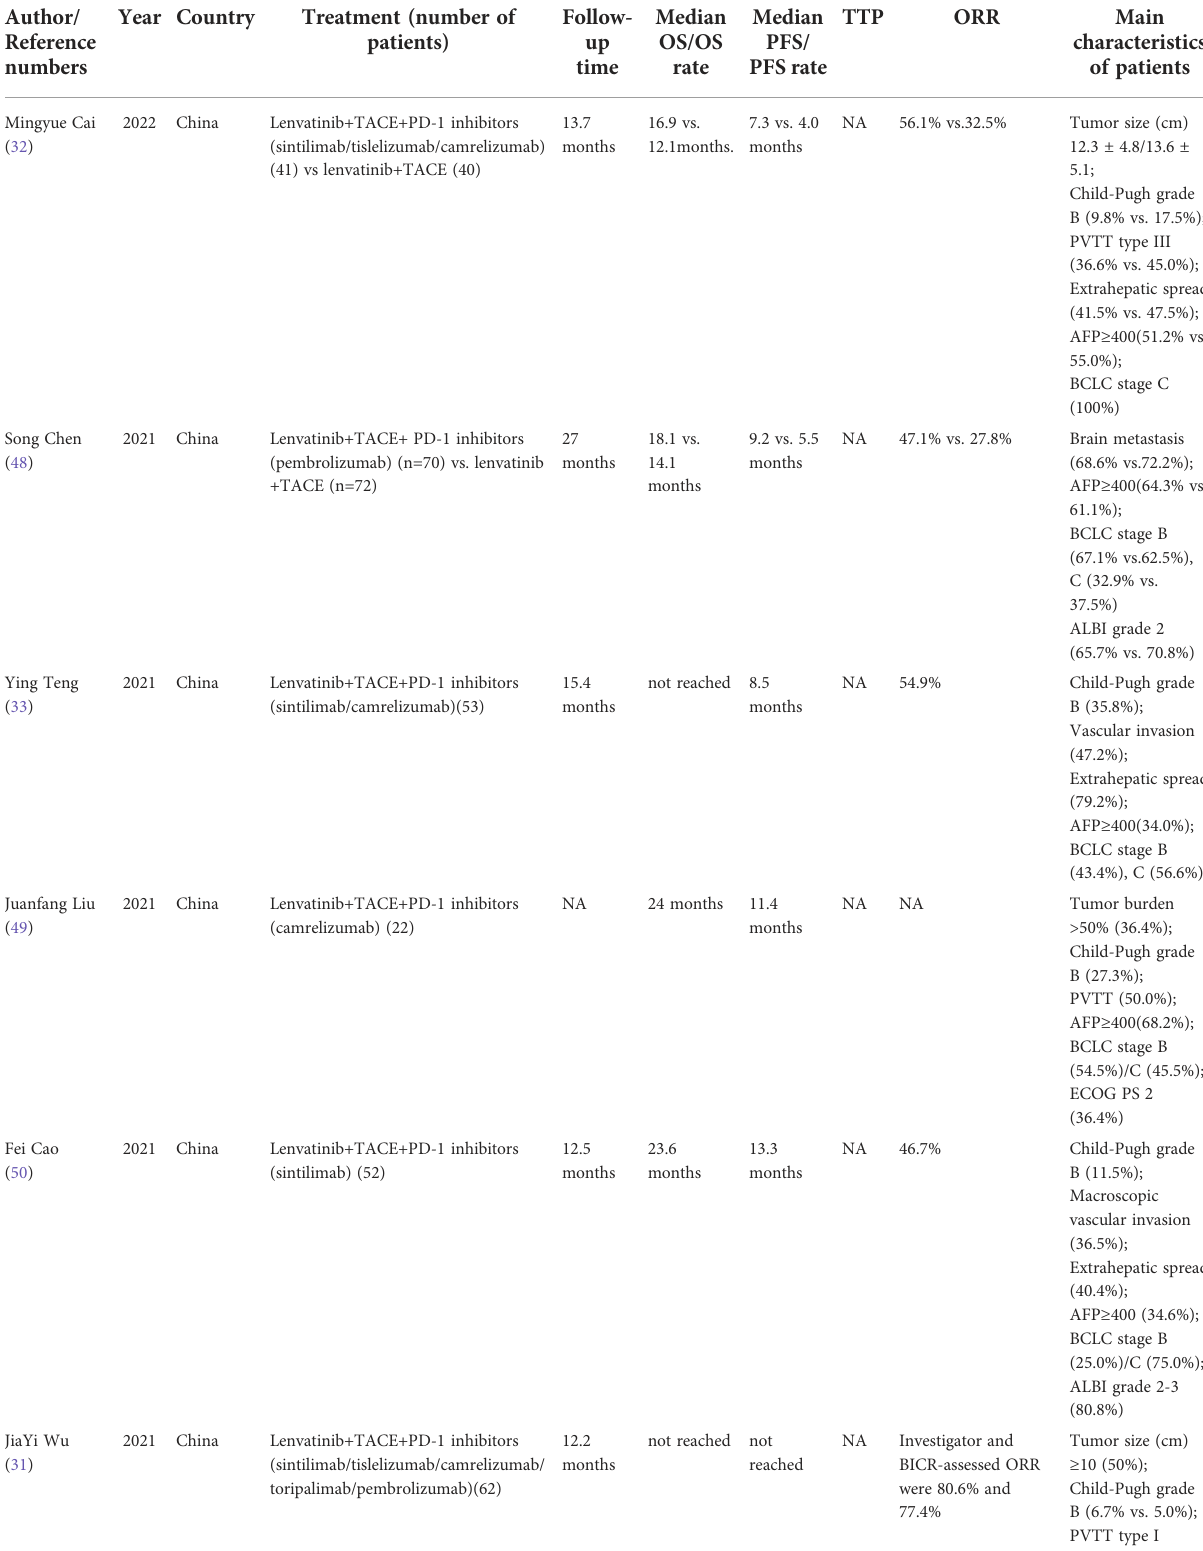
TABLE 3 Lenvatinib plus TACE combined with PD-1